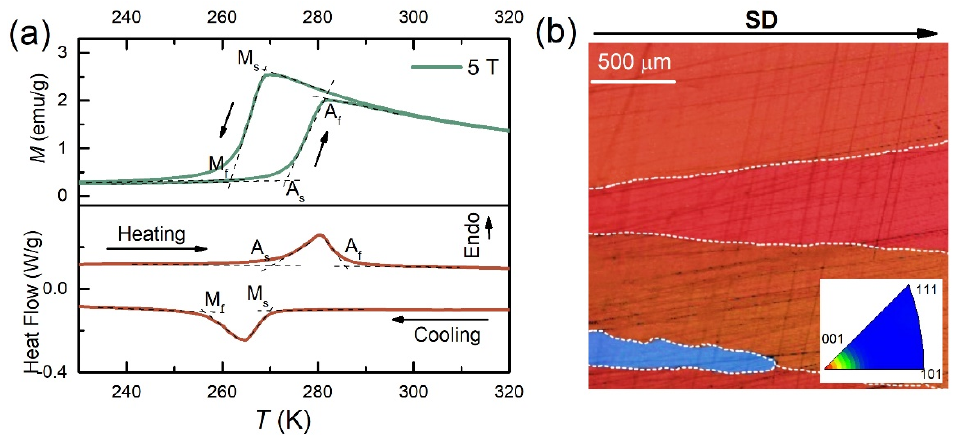
Figure 1. ( a ) DSC without magnetic field and M-T curves at 5 T for the directionally solidified Co 51.6 V 31.4 Ga 17 alloy. ( b ) EBSD orientation micrograph (IPF mode) of the longitudinal section for the directionally solidified Co 51.6 V 31.4 Ga 17 alloy at room temperature. The inset shows the inverse pole figure.